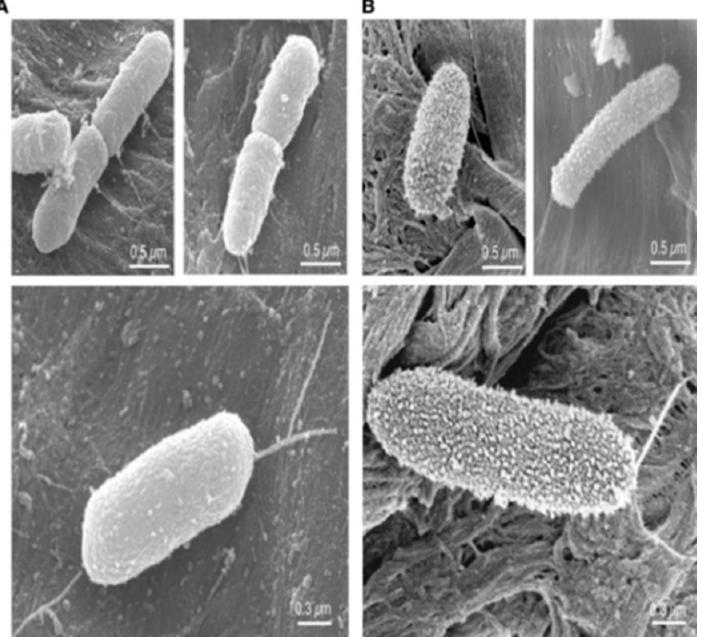
Figure 13. SEM images of P. aeruginosa in contact with cellulose membrane: ( A ) without peptide; ( B ) with an active tethered peptide. Reproduced from [80]. Copyright © 2009 Elsevier Ltd. All rights reserved.